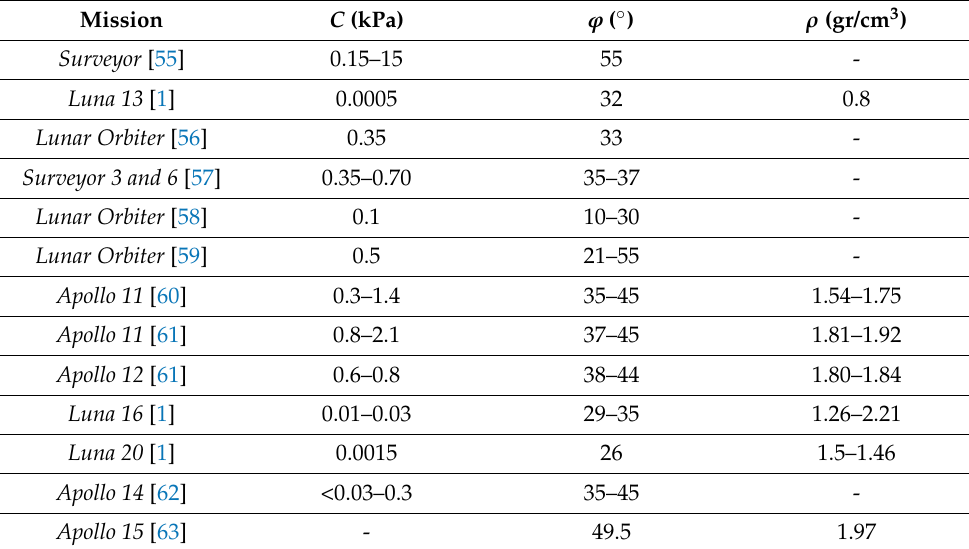
Table 1. Physical and geotechnical characteristics of the lunar